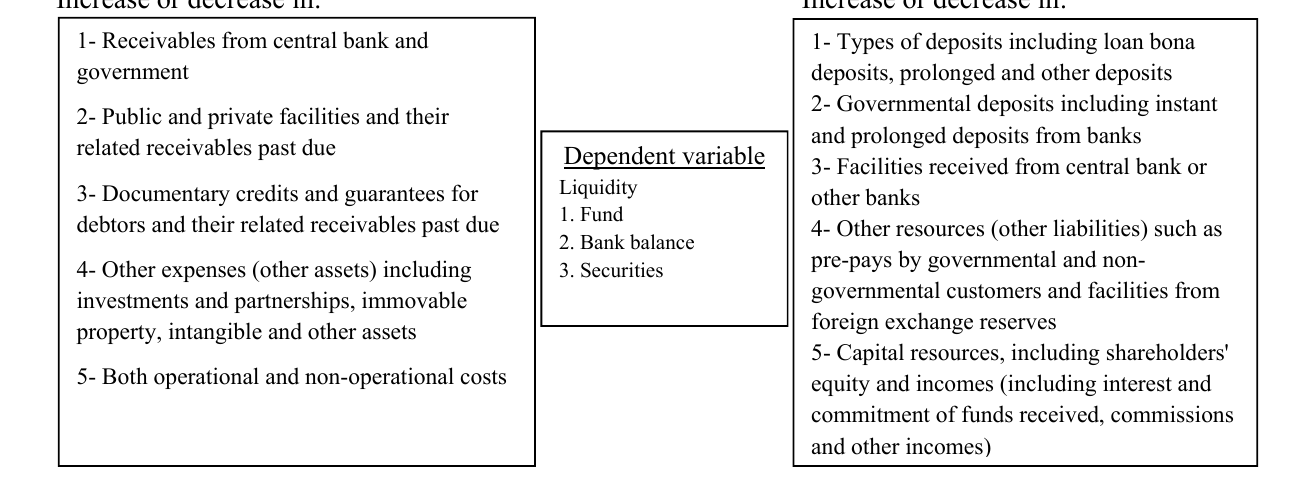
Fig. 1. Analytical model of research Descriptive statistics of the data (non-coefficient numbers are in Million Rials) Standard Variables Mean Mein Variance